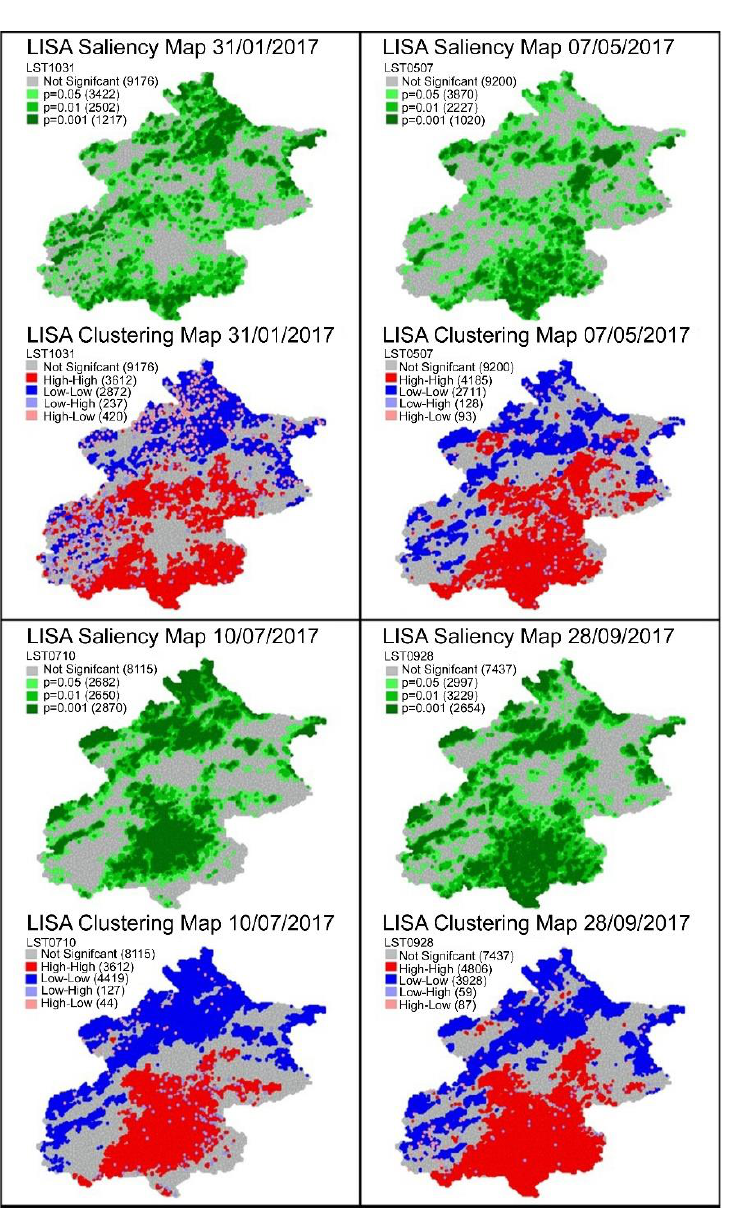
Figure 7. LISA Saliency Maps and LISA Clustering Maps: 31 January 2017, 7 May 2017, 10 July 2017, and 28 September 2017. The LISA clustering map is composed of grey, red, blue, light blue, and light red colors, and these colors correspond to five different types of spatial correlations: nonsignificant, H-H, L-L, L-H, and H-l, respectively. In the map of the 4 LST periods, H-H and L-L account for a higher proportion (39.7%, 42.3%, 49.2%, and 53.5%), which shows that the spatial clustering of LST has a dominant position. Except for during winter, H-H is mainly distributed in urban areas, L-L is mainly distributed in mountainous areas, and L-